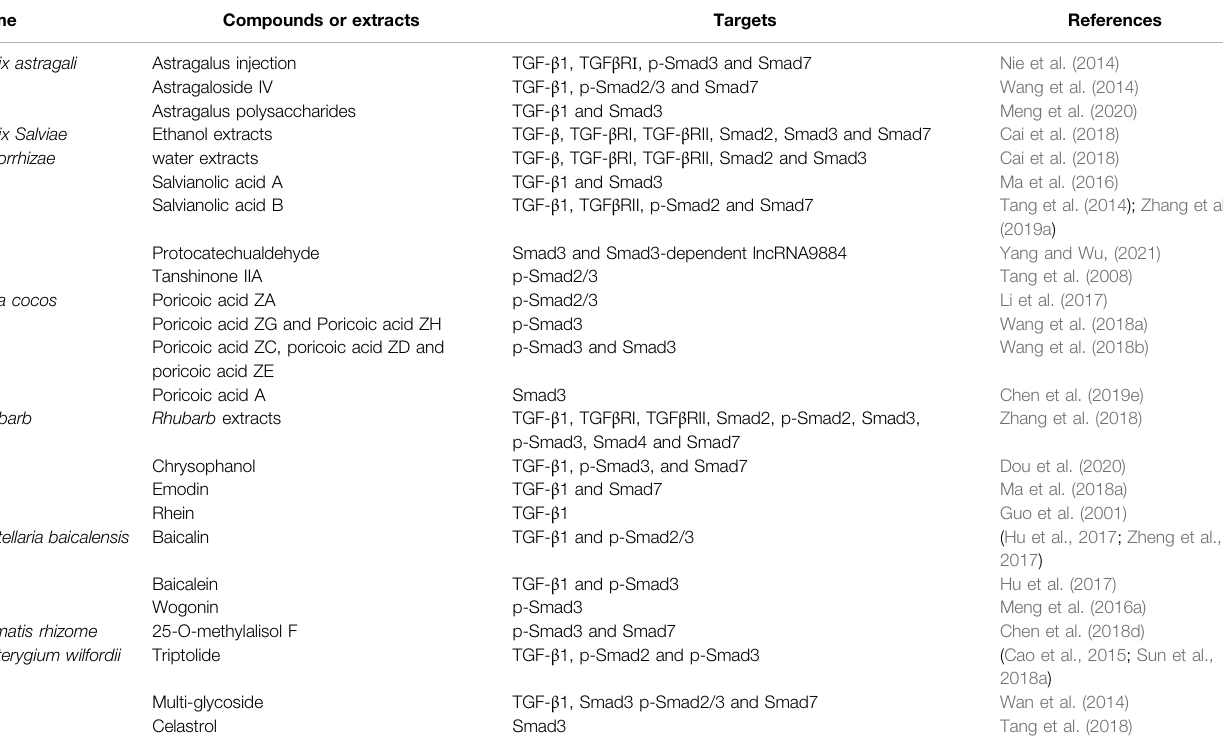
TABLE 1 | Summary of targets for natural products and their isolated compounds or extracts to exert anti-tubulointerstitial fi brosis effects through TGF- β /Smad signaling